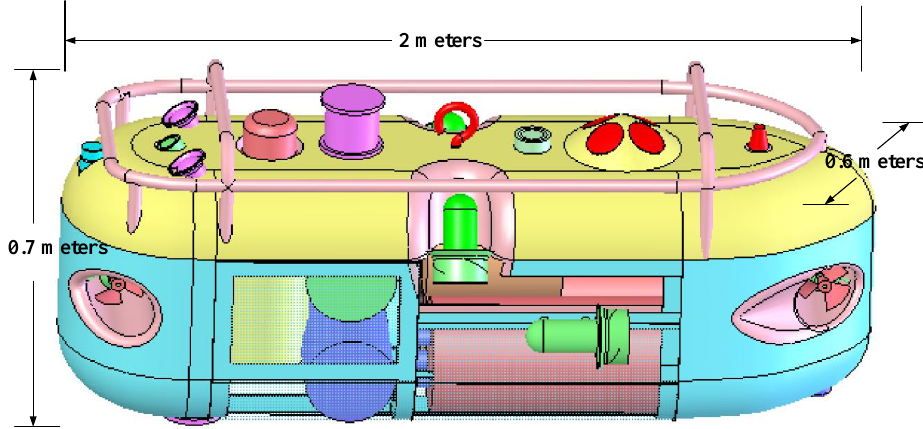
Figure 2. Schematic diagram of “Arctic AUV” structure.